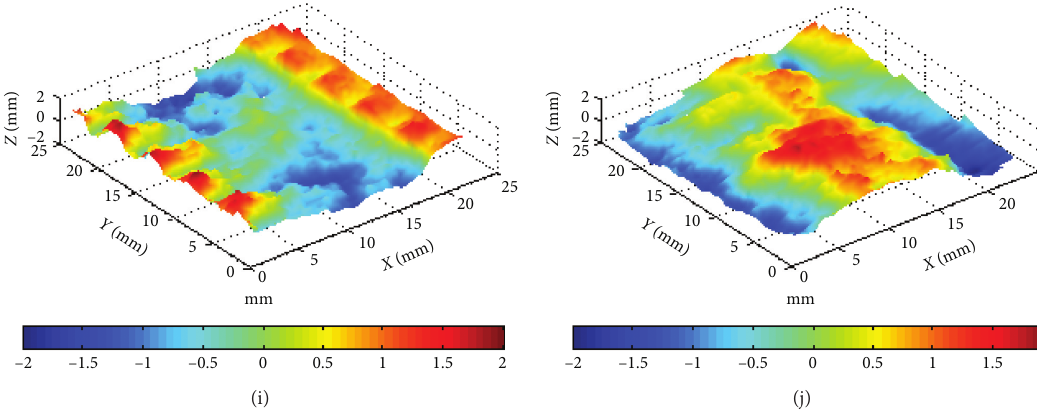
Figure 11: Reconstruction of the fracture surface morphologies. (a) CJ0-Sa. (b) CJ0-Da. (c) CJ1-Sb. (d) CJ1-Dc. (e) CJ3-Sc. (f) CJ3-Db.